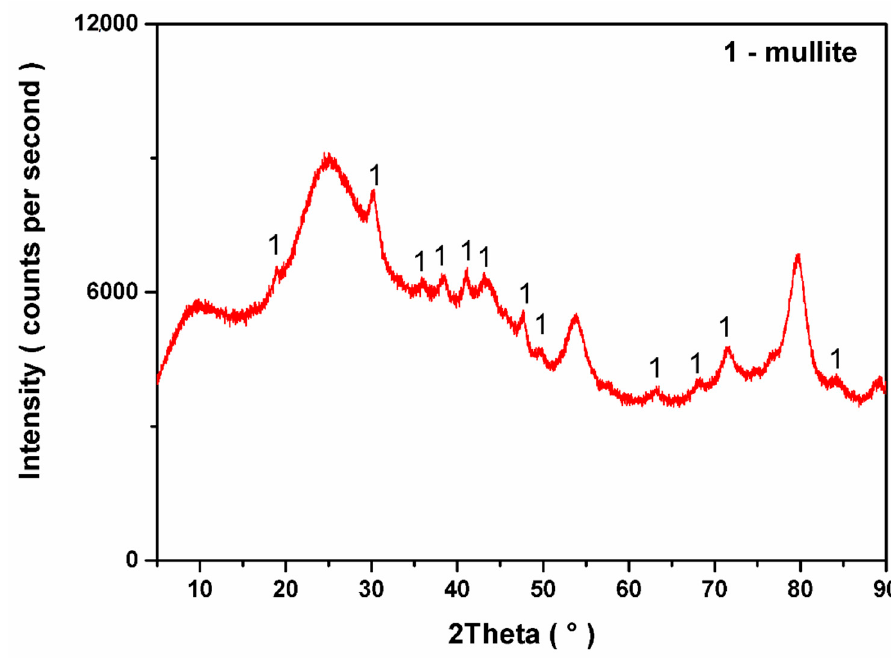
Figure 5. XRD patterns calcined at 1000 °C—start of mullite formation.